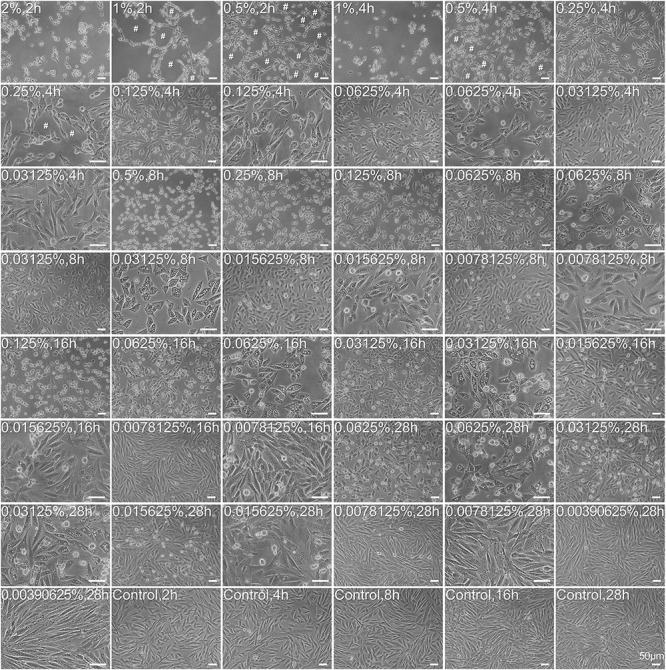
Morphological abnormality and growth status of carteolol-treated HCECs. The concentration and exposure time of carteolol were indicated on the top-left of each image. Images represent n = 3. # denotes the cytopathic effect. Scale bar is 50 μm.